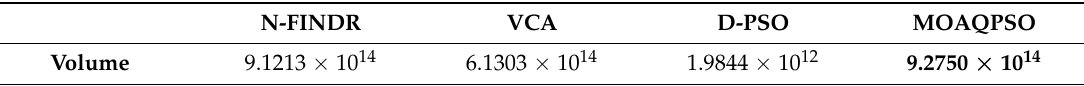
Table 6. Comparison between the RMSEs of N-FINDR, VCA, D-PSO, and MOAQPSO. Table 5. Comparison between the simplex volumes obtained by N-FINDR, VCA, D-PSO, and MOAQPSO.